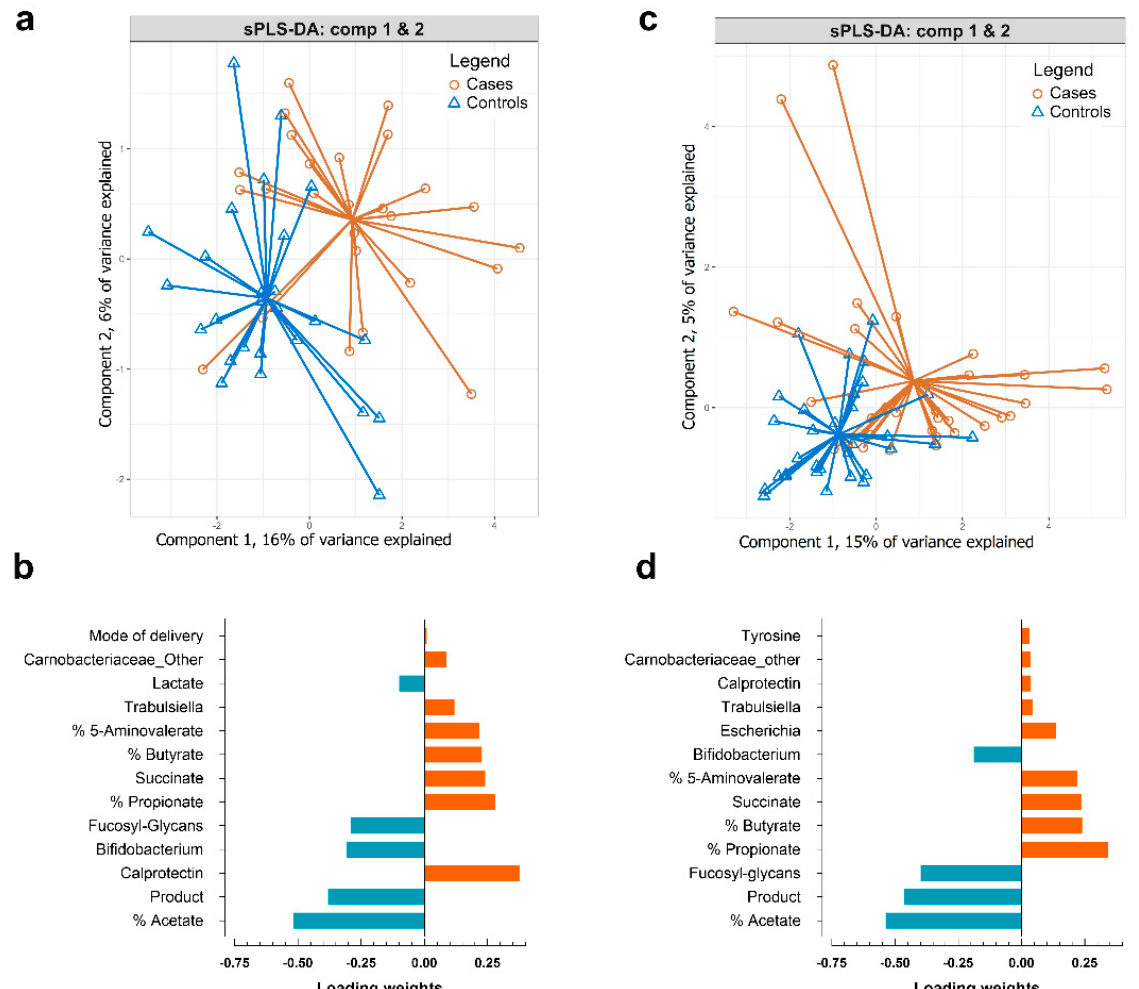
Figure 2. Representative sPLS-DA plots and loadings of the five independent rounds of sPLS-DA modeling with down- sampling to separate controls and cases for bronchitis ( n = 52) ( a , b ) and LRTI ( n = 66) ( c , d ). Results from all five sPLS-DA modeling rounds for both bronchitis and LRTI are provided in Table S1.